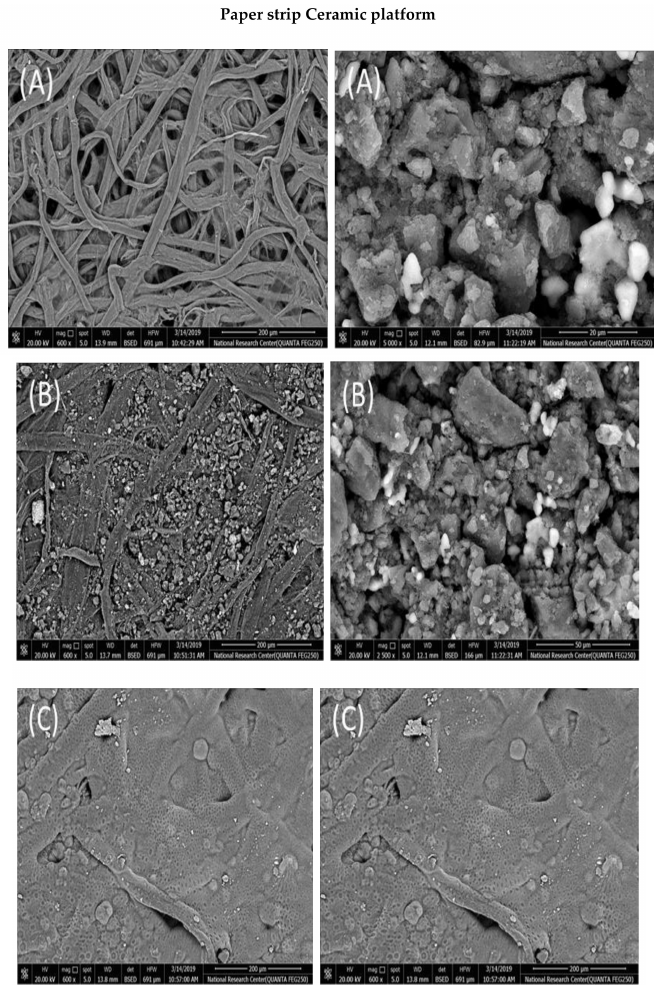
Figure 1. SEM images of the paper and ceramic substrates treated with ( A ) Conductive carbon; ( B ) Conductive carbon + polyaniline (PANI); and ( C ) Conductive carbon + PANI + poly (vinyl chloride) (PVC) sensing